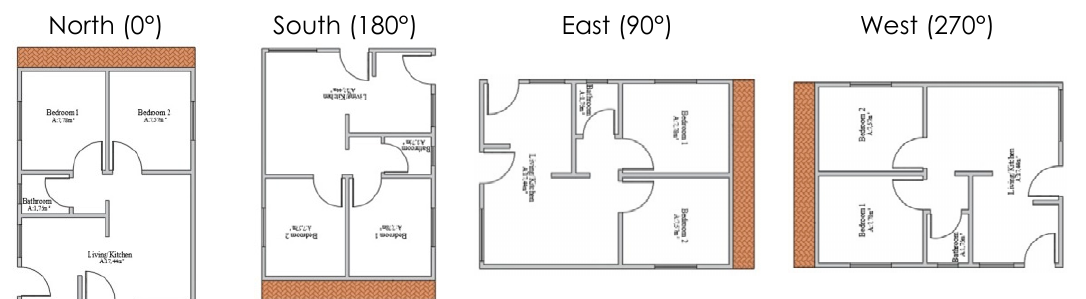
Figure 4. Variation of the embedded earth-sheltered wall orientation.